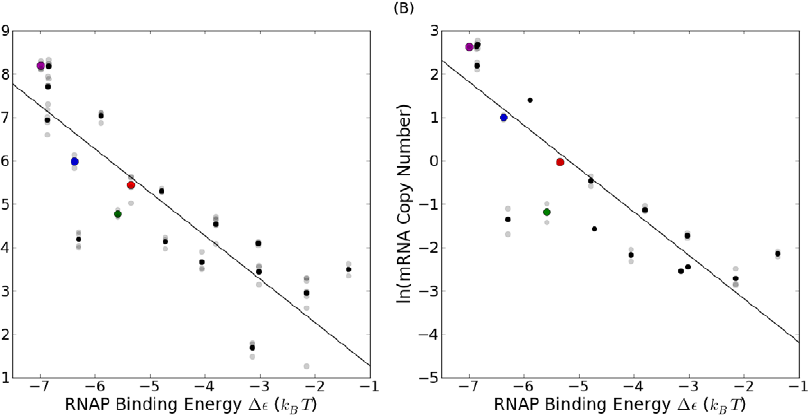
Figure 5. Gene expression as a function of RNAP binding energy. (A) LacZ activity measured in Miller units and (B) average mRNA per cell vs. promoter binding energy in units of k B T (with the zero of energy set to be the average interaction energy between RNAP and the the entire E. coli chromosome). To illustrate the reproducibility of our measurements, the translucent points represent individual measurements and the solid points represent the averaged value over repeated experiments. The solid black line in each plot is the Boltzmann factor scaling, ! e ( { D E = k B T ) . The red data points correspond to the wild-type lac promoter, which was used to calibrate the arbitrary units of our energy matrix to (physical) k B T units. The magenta, red, blue, and green data points represent promoters which we examine in the context of simple repression.